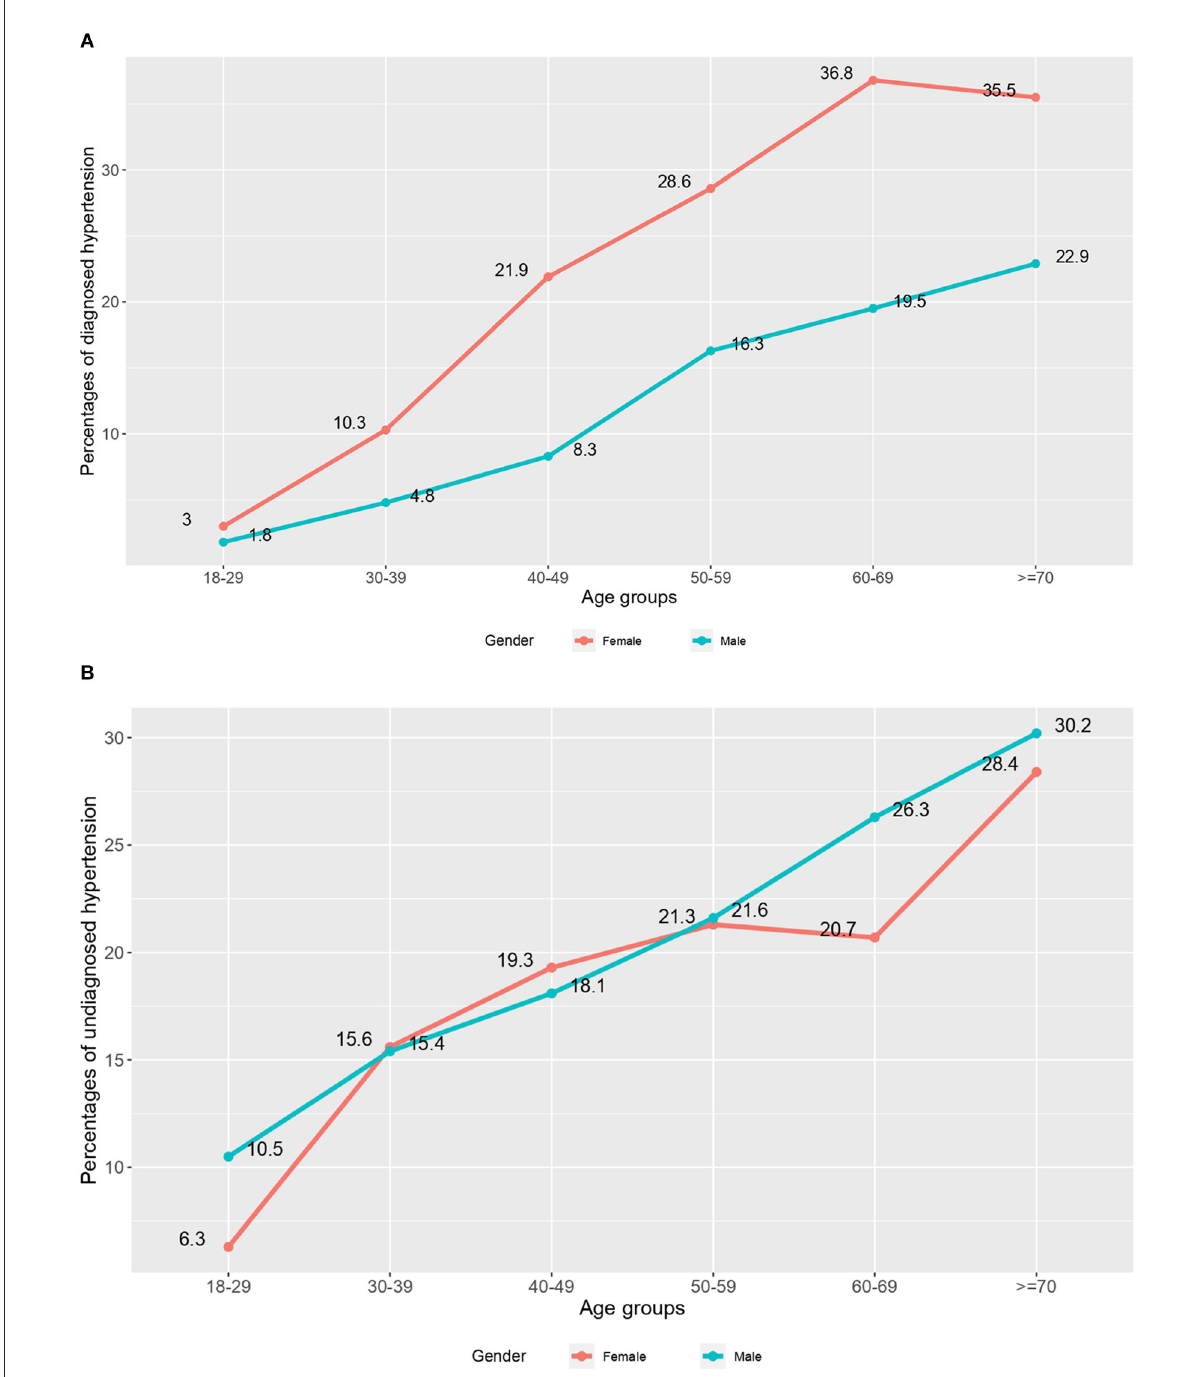
FIGURE2 (A) Prevalence of diagnosed hypertension by age and gender. (B) Prevalence of undiagnosed hypertension by age and gender.